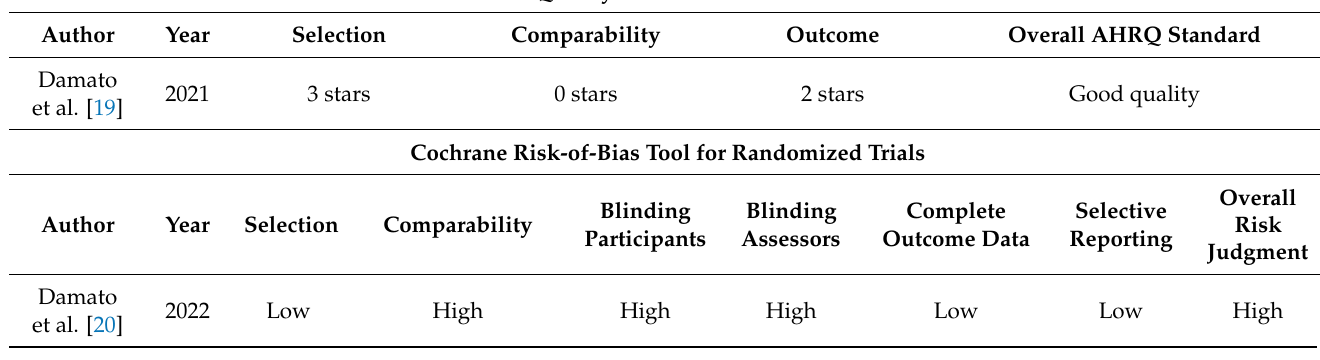
Table 2. Risk-of-bias assessment of all eligible studies.